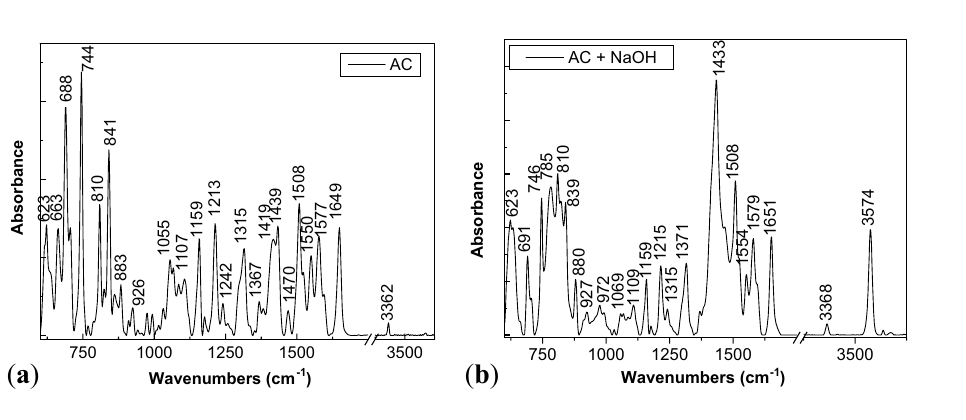
Figure 8. Raman spectra of ATC interacted with NaOH ( a ). ( a 1 , a 2 ) show spectral ranges 950–1250/cm and 2850–3150 cm −1 .